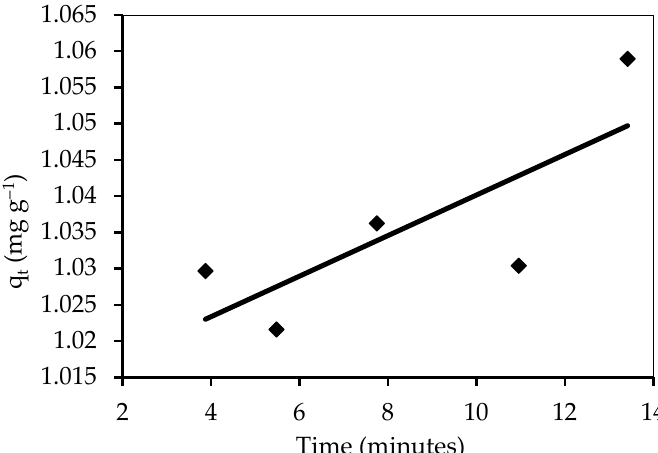
Figure 17. Adsorption kinetics of the intraparticle diffusion equation of IV2R adsorption onto ZnO-NPs.